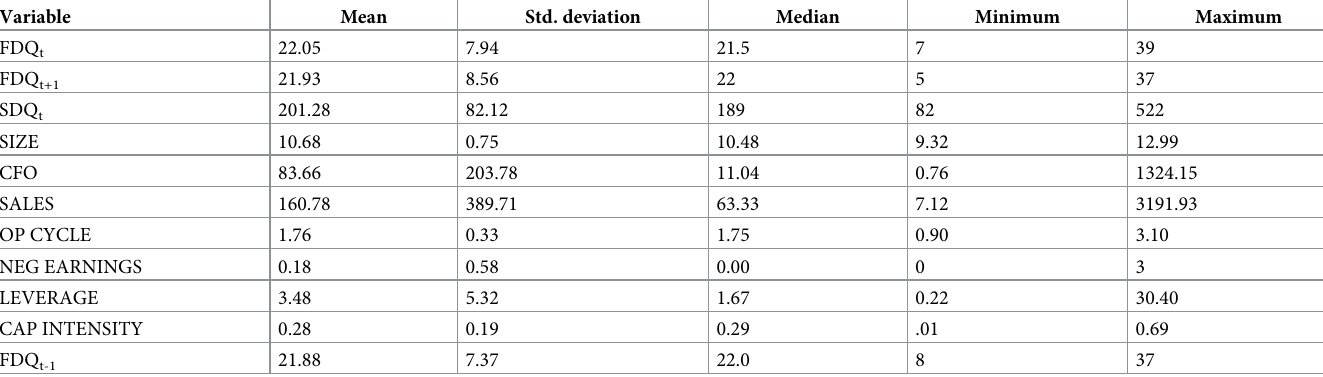
Table 2. Descriptive